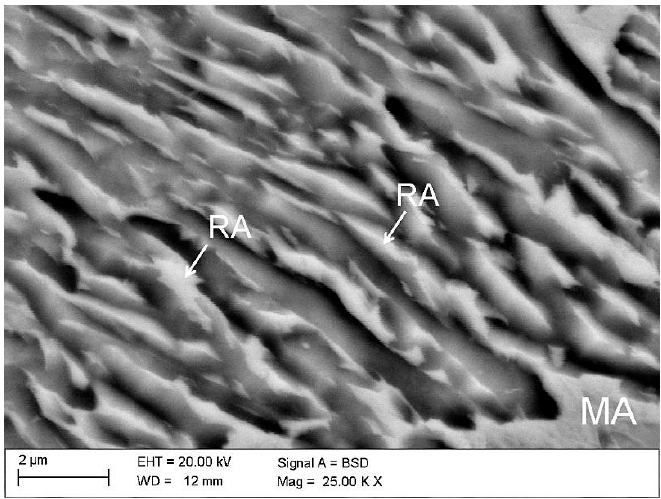
Figure 3. Microstructure of the specimen in the initial state (non ‐ deformed) characterized by bainitic laths containing retained austenite and martensite–austenite (MA) constituents; retained austenite (RA). The EBSD measurements led to determining the size, shape, and distribution of retained